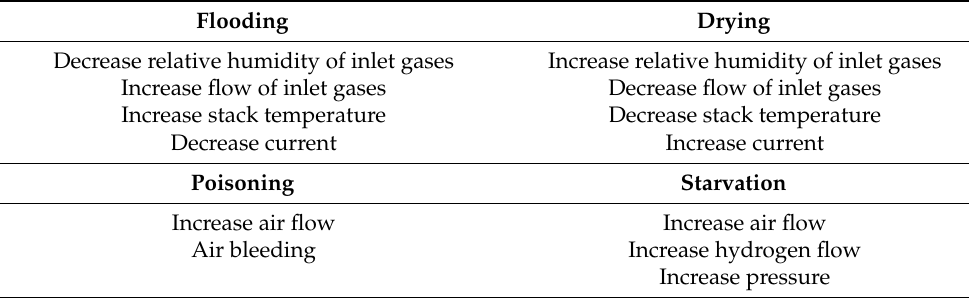
Table 3. Overview of damage mitigation measures, adapted from Aubry et al.